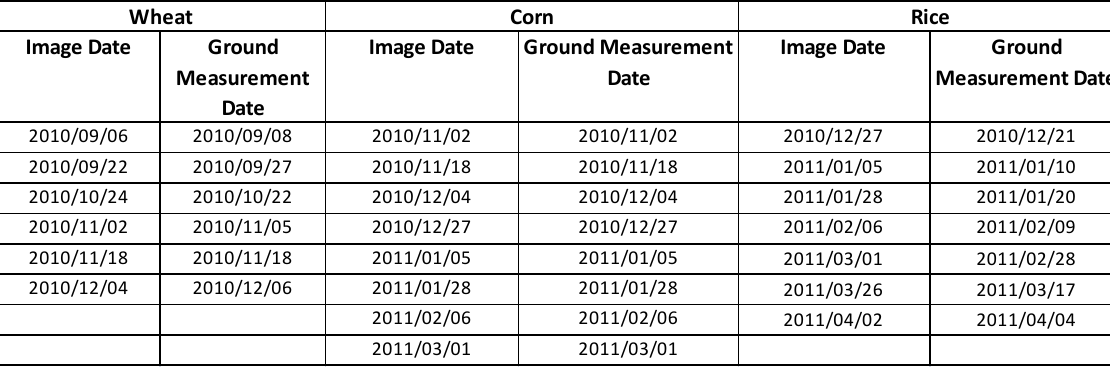
Table 1: Landsat 5 TM image acquisition dates and ground measurement dates of wheat corn and rice crops in CIA